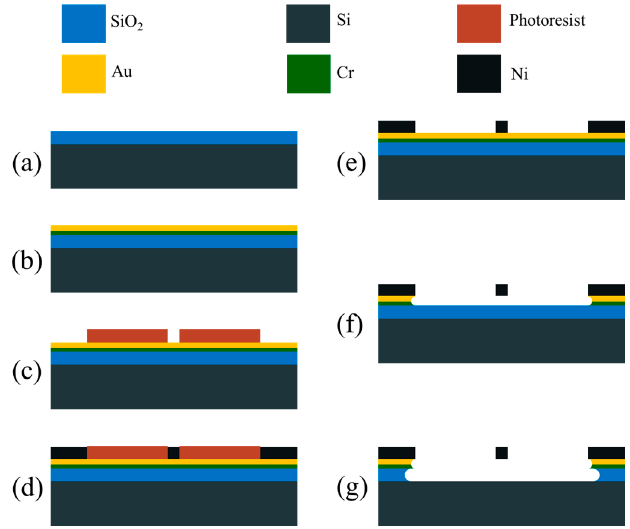
Figure 1. Fabrication process ( a ) SiO 2 coating; ( b ) Cr and Au deposition; ( c ) Photo-lithography; ( d ) Electroplating; ( e ) Photoresist Removal; ( f ) Au and Cr etching; and ( g ) Release of Resonator via SiO 2